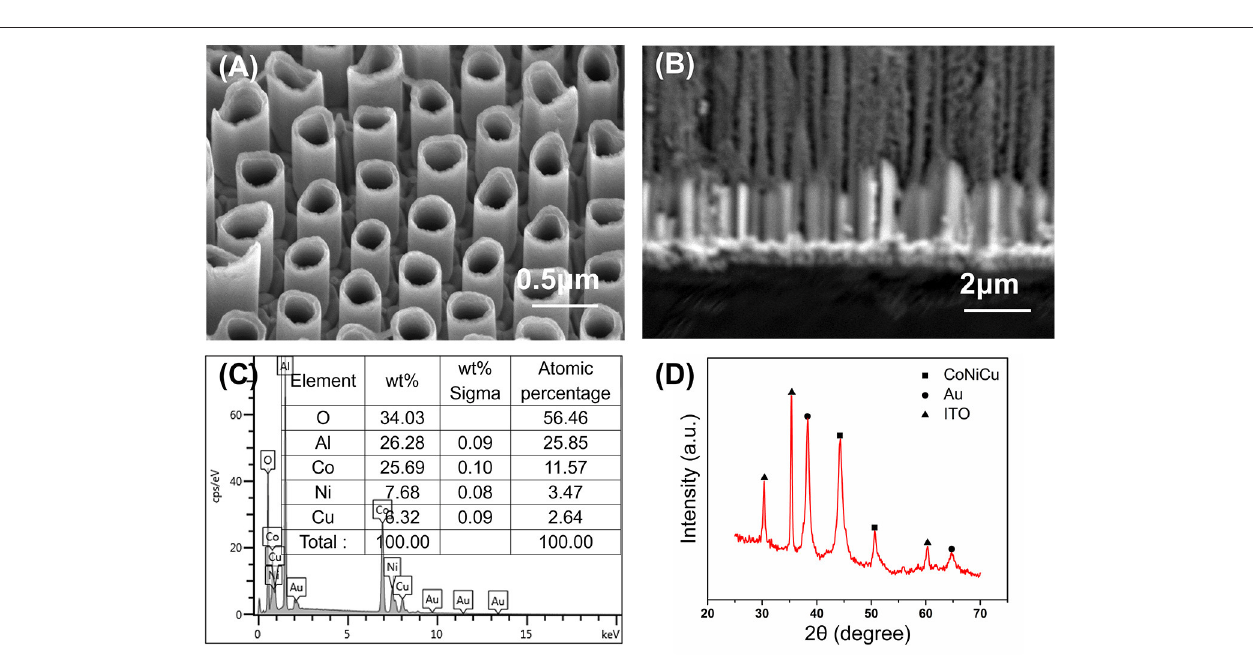
FIGURE 3 | CoNiCu nanotubes arrays with applied potential − 1.0V (A) dissolving the AAO template; (B) cross-section image embedded in AAO channels; (C) energy dispersive spectra of CoNiCu embedded in AAO channels; (D) XRD patterns of prepared nanotubes arrays transferred on ITO.